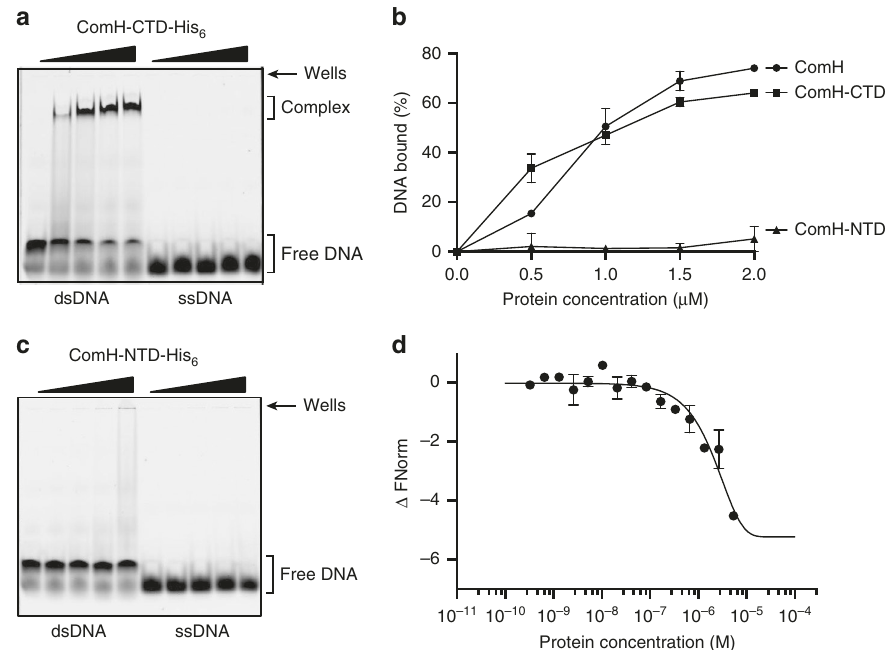
Fig. 4 ComH binds to dsDNA through its C-terminus. EMSA analysis of DNA interaction by puri fi ed a ComH-CTD-His 6 , and c ComH-NTD-His 6 with dsDNA (18 bp) and ssDNA (18-mer). Increasing concentrations of puri fi ed His 6 fused ComH domains (0, 0.5, 1, 1.5, and 2 µ M) were tested for binding with indicated DNA substrates (30 nM). Representative images of resolved gels are shown. Quanti fi cation of the bands from Figs. 4a and 4c was performed using ImageJ and the percentage binding is displayed in b . Error bars represent standard deviation from at least two independent experiments. d Interaction measurements by microscale thermophoresis of the af fi nity between ComH-CTD-His 6 and a 18 bp DNA labelled with a FAM in 5 ’ . All experiments were performed in duplicate. Error bars represent standard deviation from at least two independent